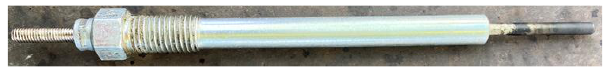
Fig. 5. A glow plug failure due to overheating for the NGK Y508J 11V glow plug used in the 2007 IA Sorento 2.5 CRDI engine. Source: own elaboration